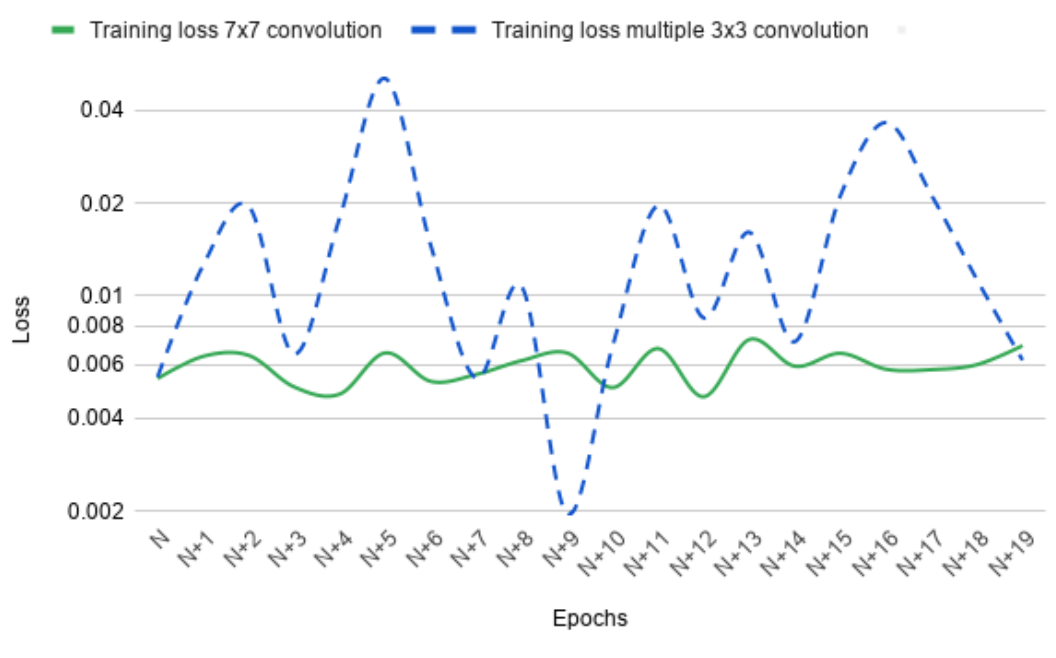
Figure 2. Training loss of two different type convolution networks. The training loss was extracted from a 20 epoch window while training. N depicts the start of the window and the loss was plotted for each epoch. Training loss of convolution network with two different kernel sizes (3 × 3 and 7 × 7) are